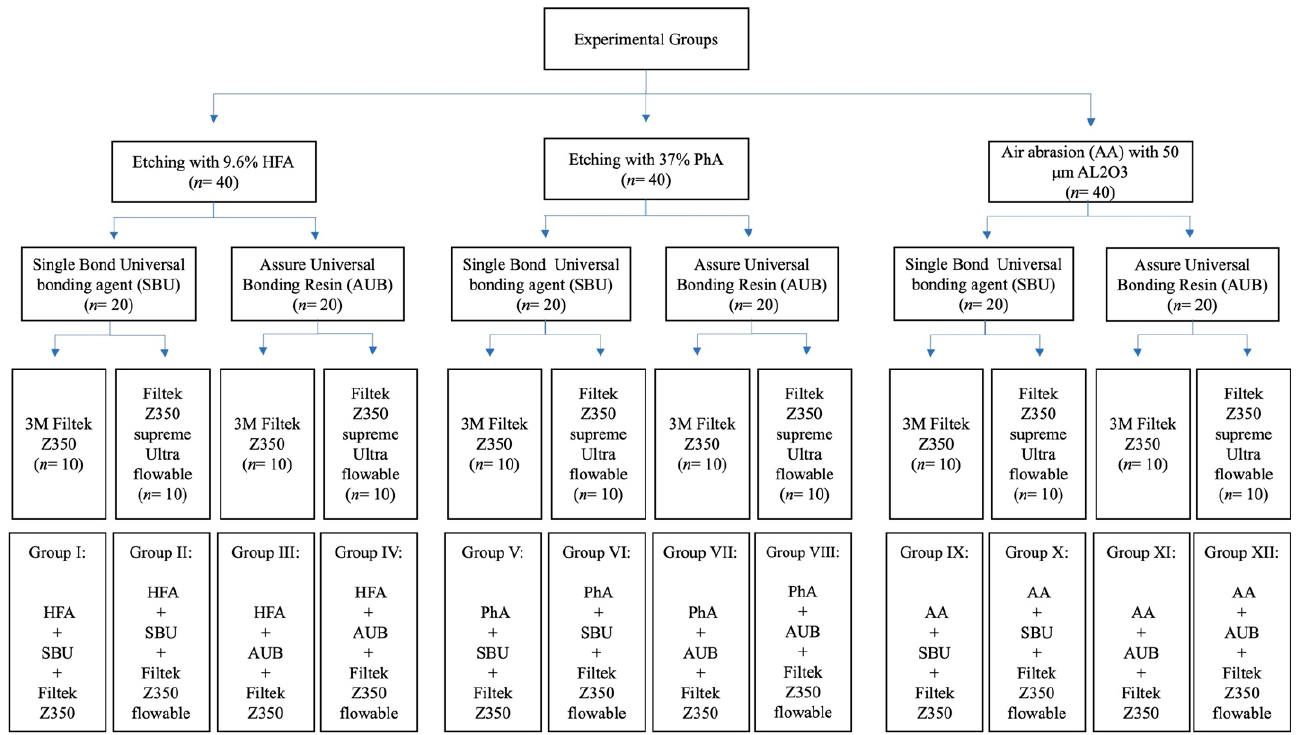
Figure 1. SBS experimental flowchart and groups. After surface treatments, bonding adhesives were applied. For the SBU